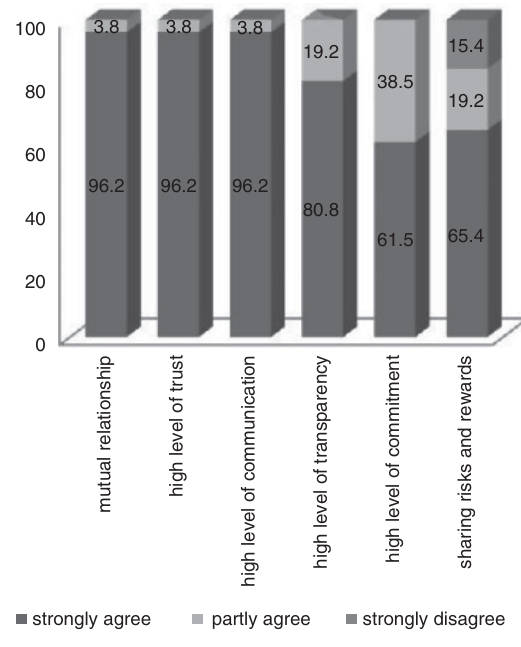
Fig. 6. The factors contributing to success with logistics